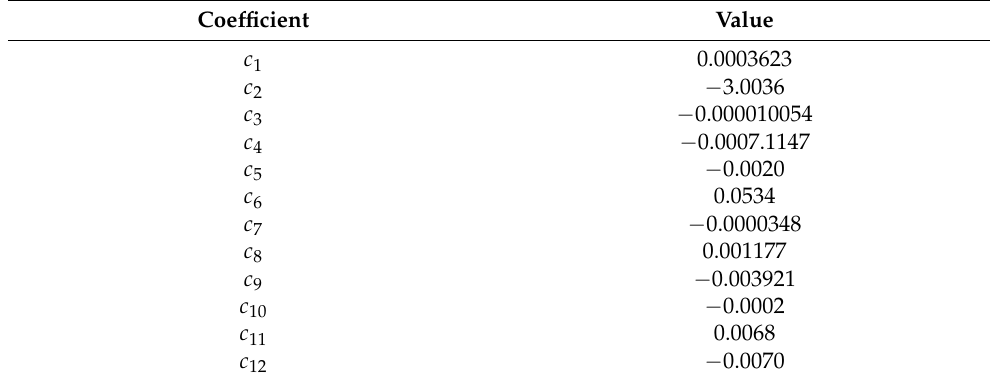
Table 3. Coefficients of the expression approximating the clutter loss statistics for H S = 18